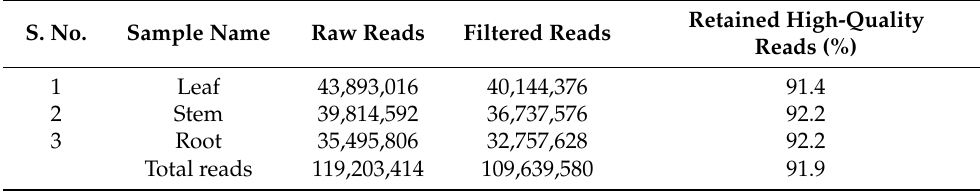
Table 1. Total raw and filtered reads generated for leaf, stem, and root tissues of A. glauca . S. No.